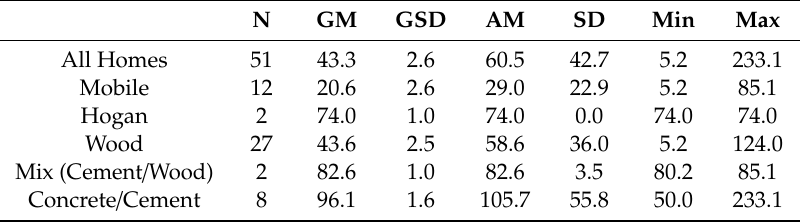
Table 4. Mean Indoor Radon Concentration [Bq/m 3 ] Level by Navajo Nation Agency. Crawl Space